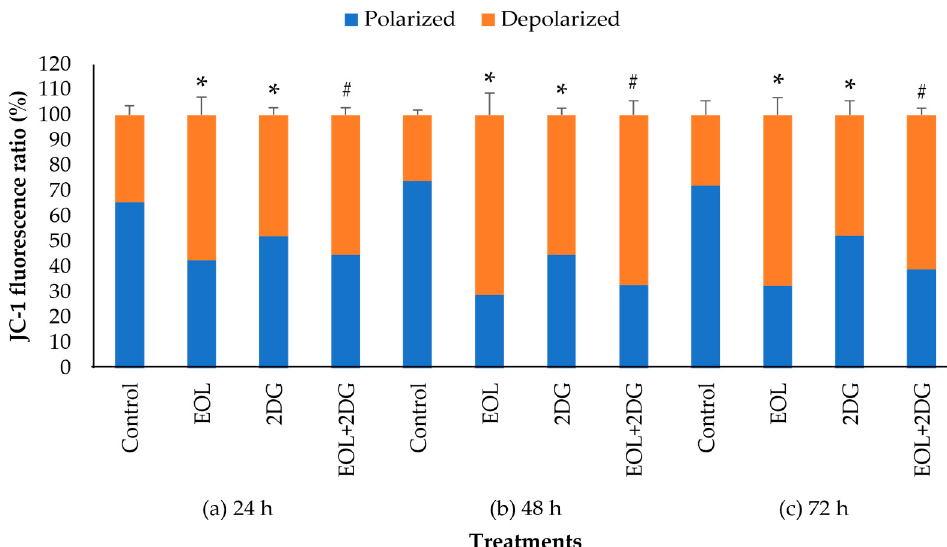
Figure 9. A quantitative analysis of mitochondrial membrane potential in PANC-1 cells: The percentages of polarized and depolarized cells after ( a ) 24 h, ( b ) 48 h and ( c ) 72 h exposures to culture medium (vehicle control), EO-L, 2-DG and EOL+2DG, respectively. The data were shown as the mean values ± S.D. for three independent experiments, and the statistical analysis of depolarized cells was determined using a Student’s t -test, with the * symbol showing a significant difference ( p < 0.05) in comparison to control untreated cells and the # symbol showing a significant difference ( p < 0.05) in comparison to